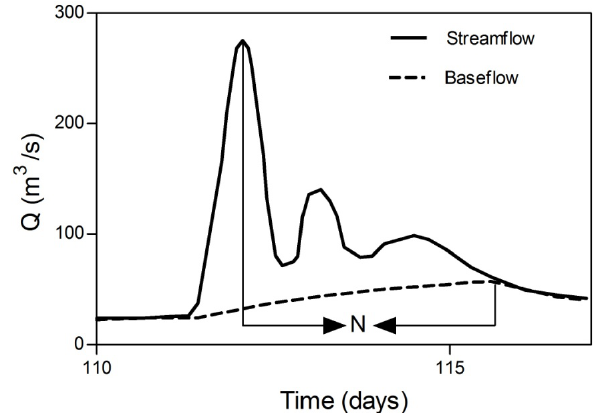
Figure 3. Graphical separation method (constant slope